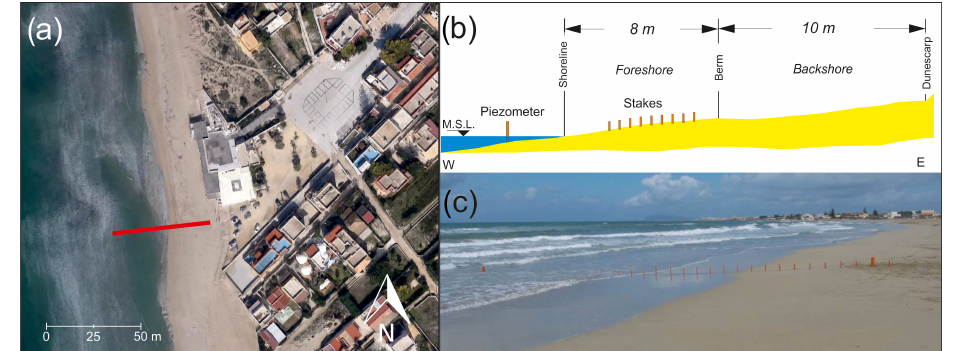
Figure 3. Plan view (a) cross-section sketch (b) and beach profile (c) of reference transect 45 (see the following section) for the run-up measurements at Lido Signorino beach. Table 1. R 2% run-up comparison between field measurements, numerical model (Lo Re et al., 2012b), and empirical formula (Nielsen and Hanslow, 1991). Wave no. Offshore Measured Boussinesq Nielsen and Hanslow